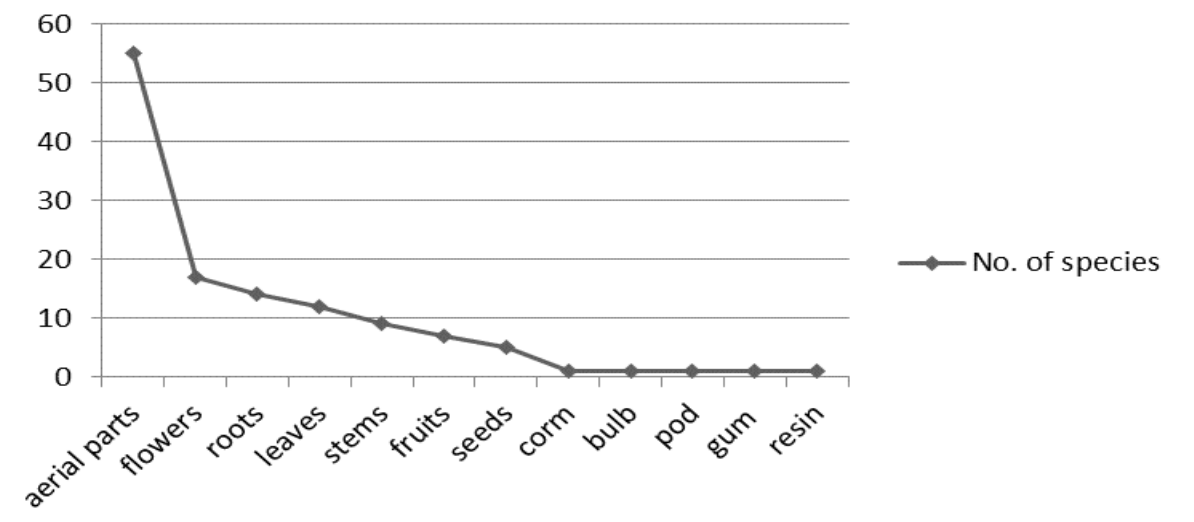
Figure 3. The plant parts of the Iranian endemic medicinal and aromatic plants in common use for curing the diverse maladies.